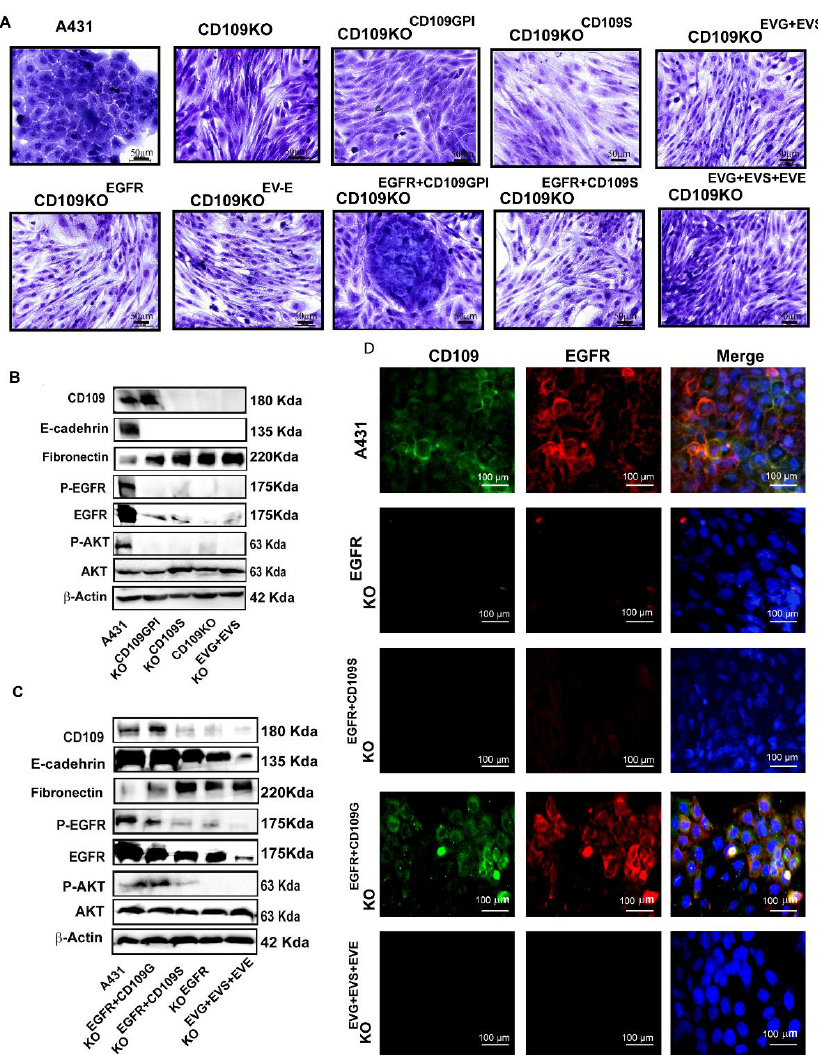
Figure 6. GPI-anchored CD109 is required for maintaining EGFR expression, levels of phospho-EGFR, and phospho-AKT, and the epithelial phenotype in CD109KO SCC cells. ( A ): Representative images of Toluidine blue staining of A431 and CD109-KO A431 cells transfected with indicated plasmids. Cell morphology was visualized by staining with 0.1% toluidine blue. ( B , C ): Western blotting analysis of cells in A for EGFR, phospho-EGFR, phospho-AKT, E-cadherin, and fibronectin. ( D ): Representative images of immunofluorescence microscopy for CD109 and EGFR using the cells indicated in ( A ). All results were repeated in three independent experiments. Scale bars: 50 µ m or 100 µ m as indicated. Uncropped WB images were shown in Figure